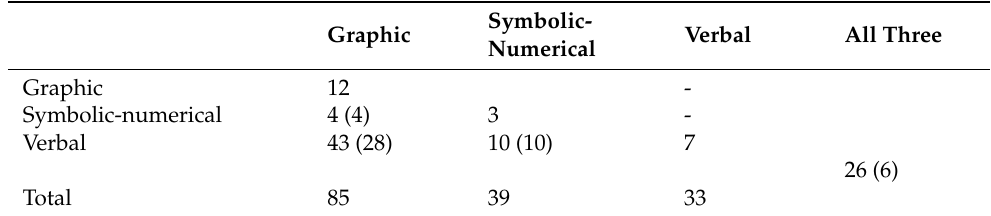
Table 6. Frequency of use of each strategy.